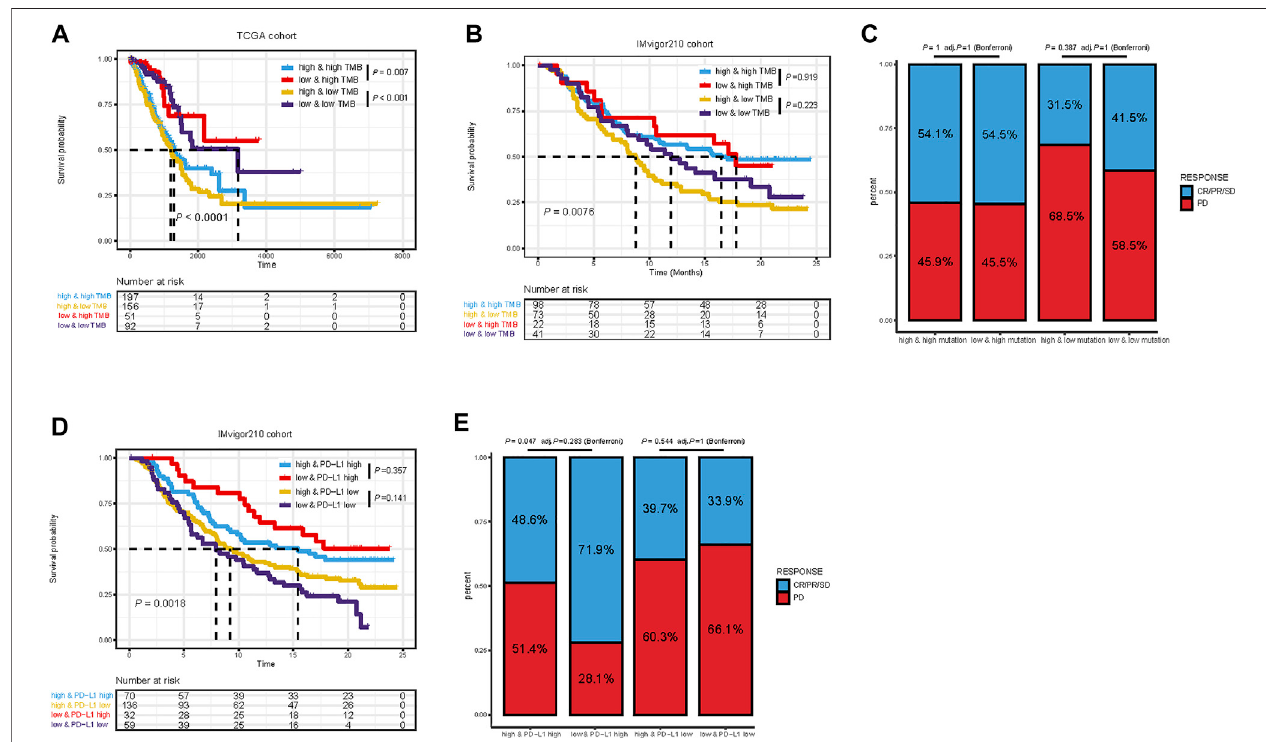
FIGURE8| Kaplan – Meiersurvivalcurvesofoverallsurvivalamongfourpatientgroupsstrati fi edbyTMEscoreandTMBinTCGAdataset (A) andIMvigor210cohort (B) .ProportionalrepresentationoftheobjectiveresponserateamongsubgroupscategorizedbyTMEscoreandTMBintheIMvigor210cohort (C) .Kaplan – Meiersurvival curvesofoverallsurvivalamongfourpatientgroupsstrati fi edbyTMEscoreandPD-L1intheIMvigor210cohort. (D) Proportionalrepresentationoftheobjectiveresponse rate among subgroups categorized by TMEscore and PD-L1 in the IMvigor210 cohort (E) . CR, complete response; PR, partial response; SD, stable disease; PD, progressive